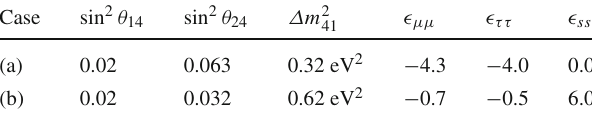
Table 1 The two sets of parameters in the ( 3 + 1 ) + NSI scenario con- sidered in this work, which come from a scan of the parameter space performed in [26]. All the other parameters of the 3+1 model and/or NSI parameters not indicated in the table are assumed to be